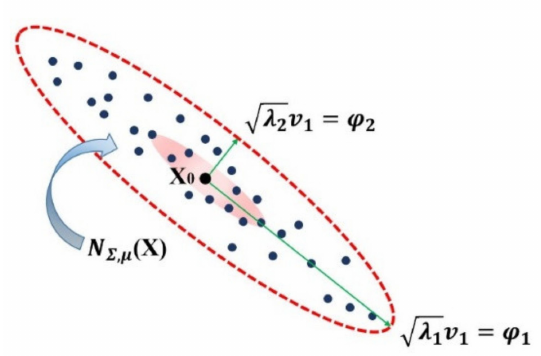
Figure 14. Graphical representation of the two directions of maximum eigenvalues. The ratio λ 2 / λ 1 represents the quality of the fit, or rather the optimal normal least- squares direction given by the eigenvector with small eigenvalue. In order to calculate the difference between volumes, it is necessary to reconstruct the surfaces of the two-point clouds. Delaunay triangulation was applied to the two models. In general, the workflow leading to the calculation of the volumes can be summarized as follows (Figure 15).